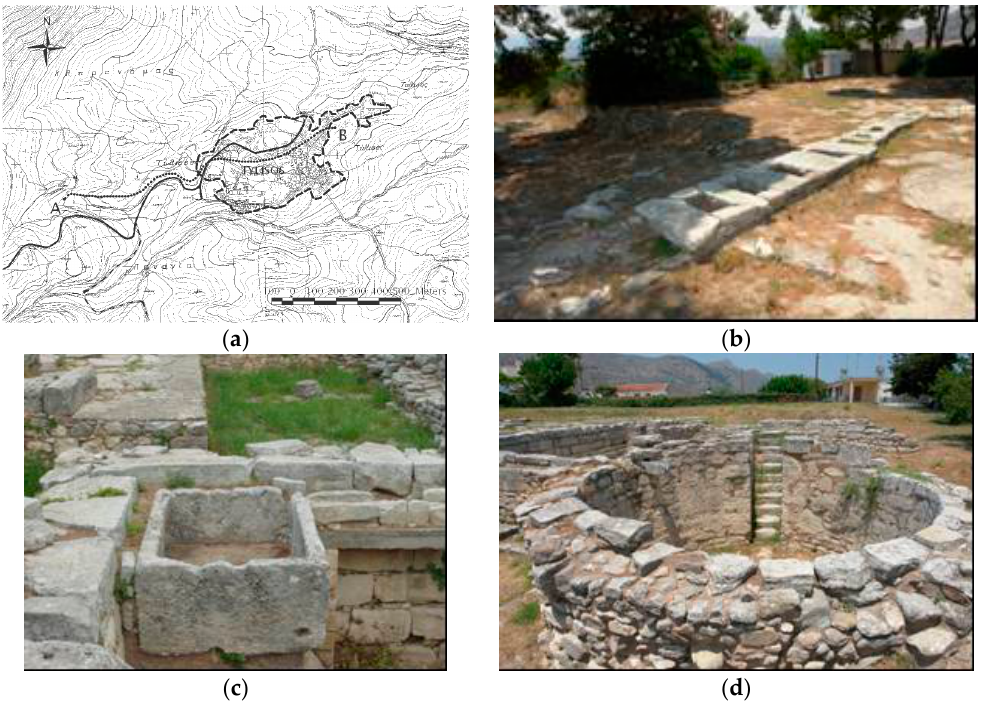
Figure 2. Tylissos aqueduct: ( a ) Possible layout (“A” spring of Agios Mammas); ( b ) part of the central conduit located at the entrance of the archeological site; ( c ) secondary conduit and small stone cistern used for removing solid particles from water before storage in the main cistern; and ( d ) central cistern in which the water was stored (with permission of A. N. Angelakis). Table 2. Characteristics of major aqueducts in Minoan Crete [7].